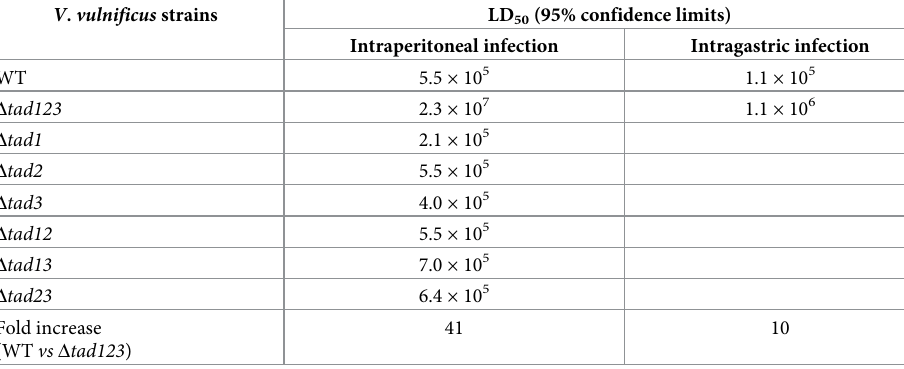
Table 1. Effect of the mutation of tad operons on the lethality for